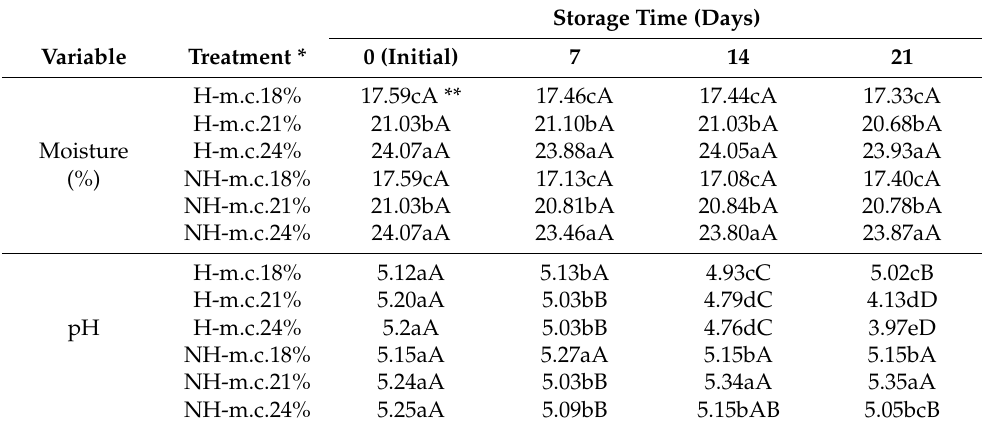
Table 2. Moisture content (%) and pH of maize at 18, 21, and 24% stored for up to 21 days in hermetic and non-hermetic jars at 25 ◦ C and 80% relative